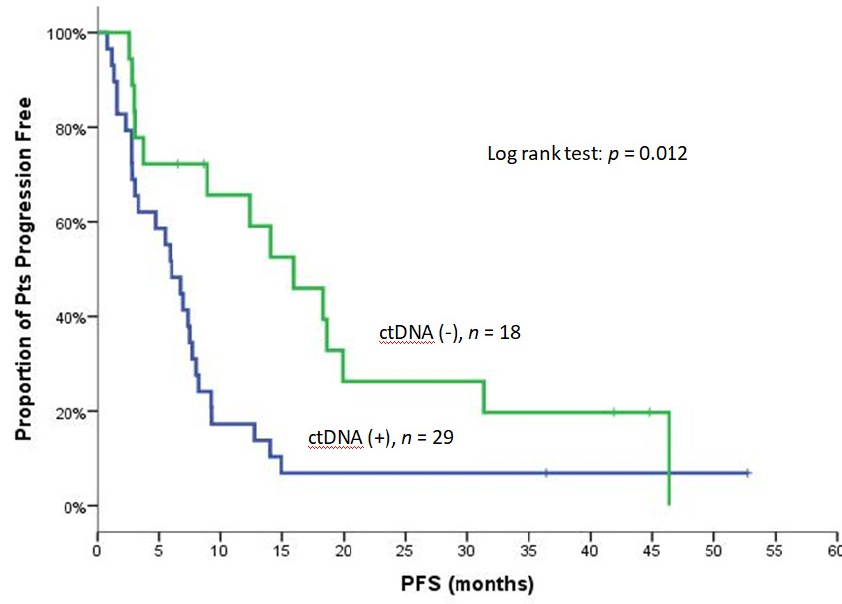
Figure 1. PFS for patients with detectable and non-detectable ctDNA at baseline.